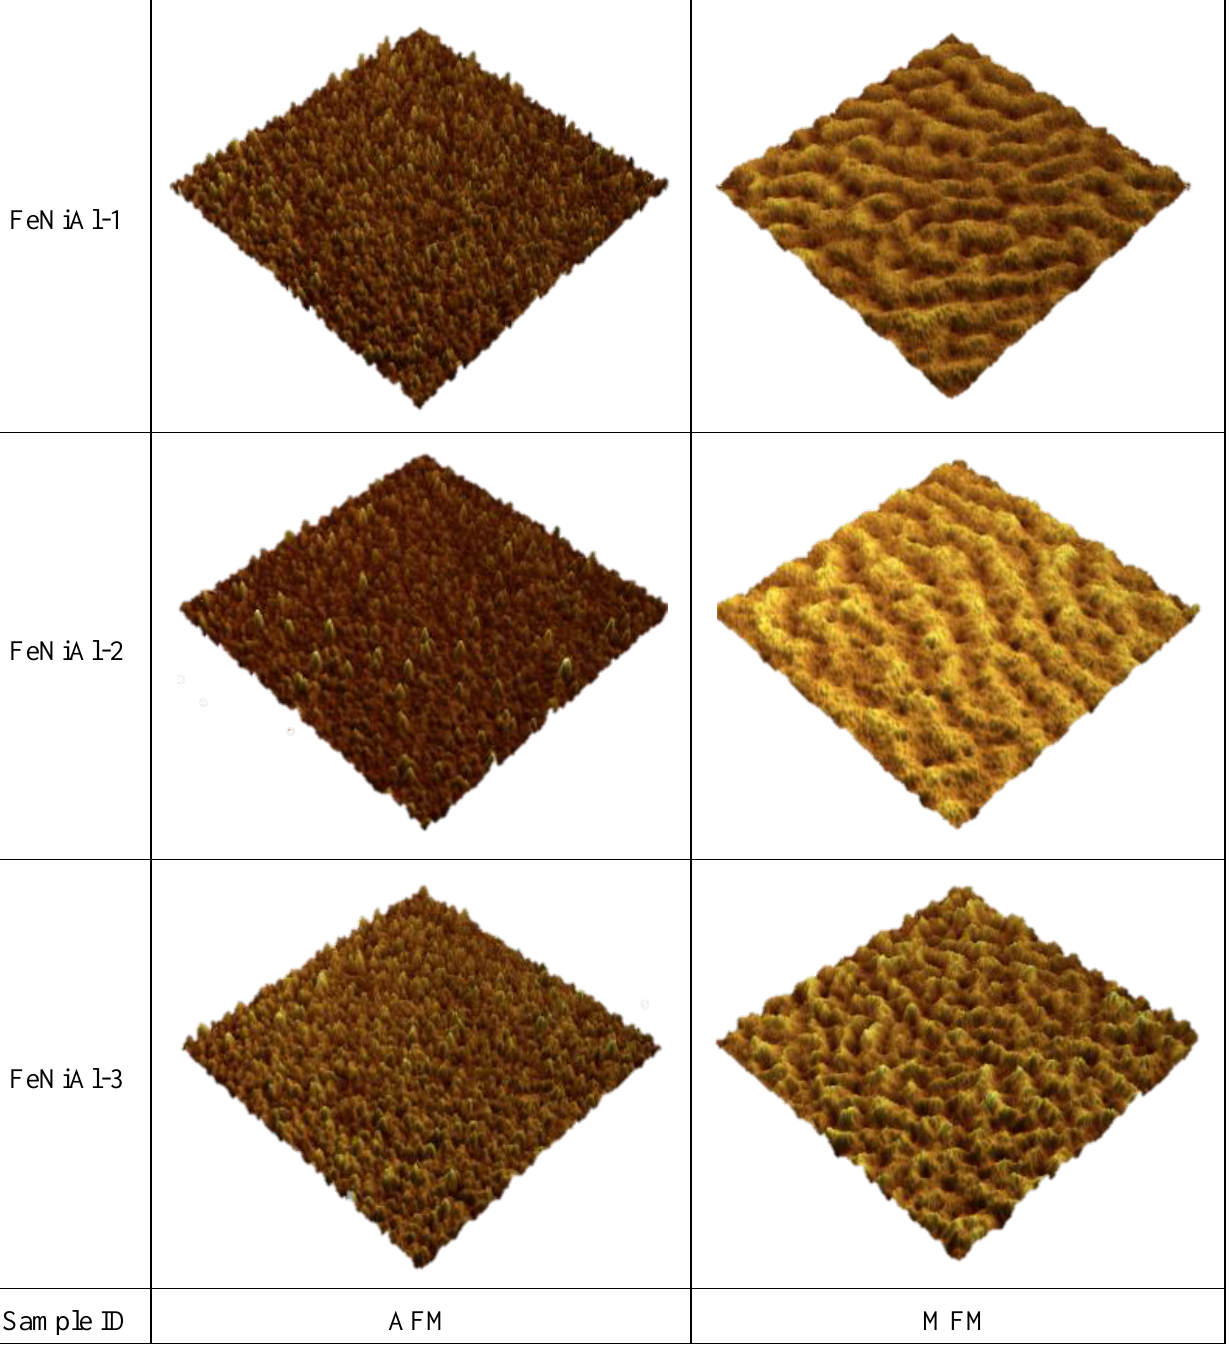
Figure 6. AFM and MFM images (size: 3 µm × 3 µm) of FeNiAl thin films in 3D visualization.